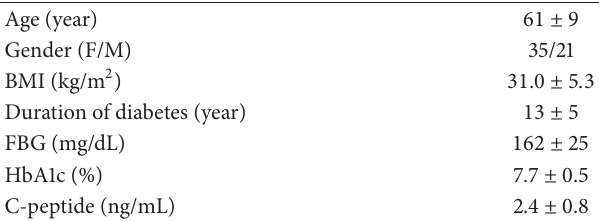
Table 1: General characteristics of the subjects ( 𝑛 = 56 ).